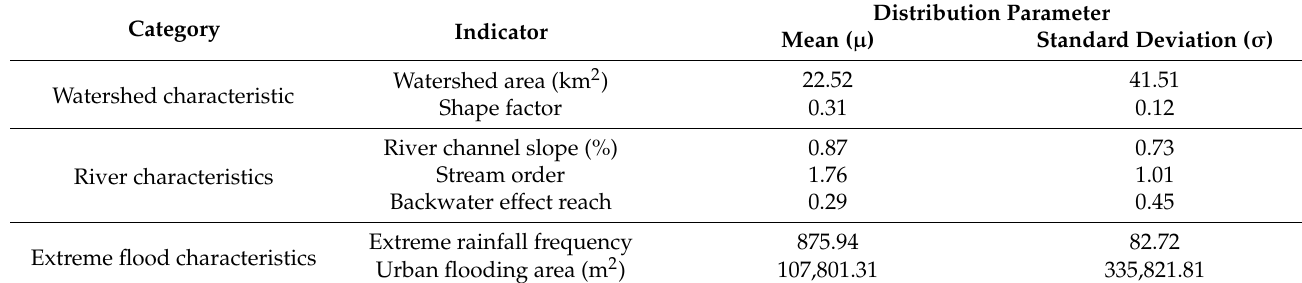
Table 1. Parameters of normal distribution for indicators.